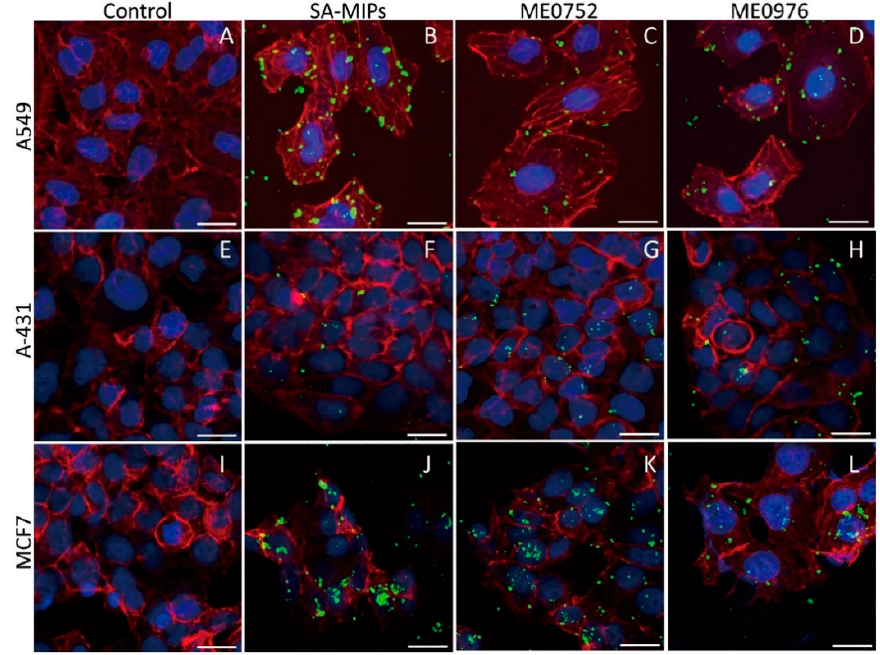
Figure 4. Confocal fluorescence microscopy images of SA-MIPs staining for three different cancer cell lines. A549 ( A – D ), A-431 ( E – H ), and MCF7 ( I – L ) were stained with SA-MIPs ( B , F , J ) in green, rhodamine-phalloidin (actin filaments) in red and DAPI (nuclei) in blue. The two columns on the right show staining with SA-MIPs after pre-treatment with the 200 µM of SA conjugates ME0752 ( C , G , K ) and ME0976 ( D , H , L ). Scale bar: 20 µm.